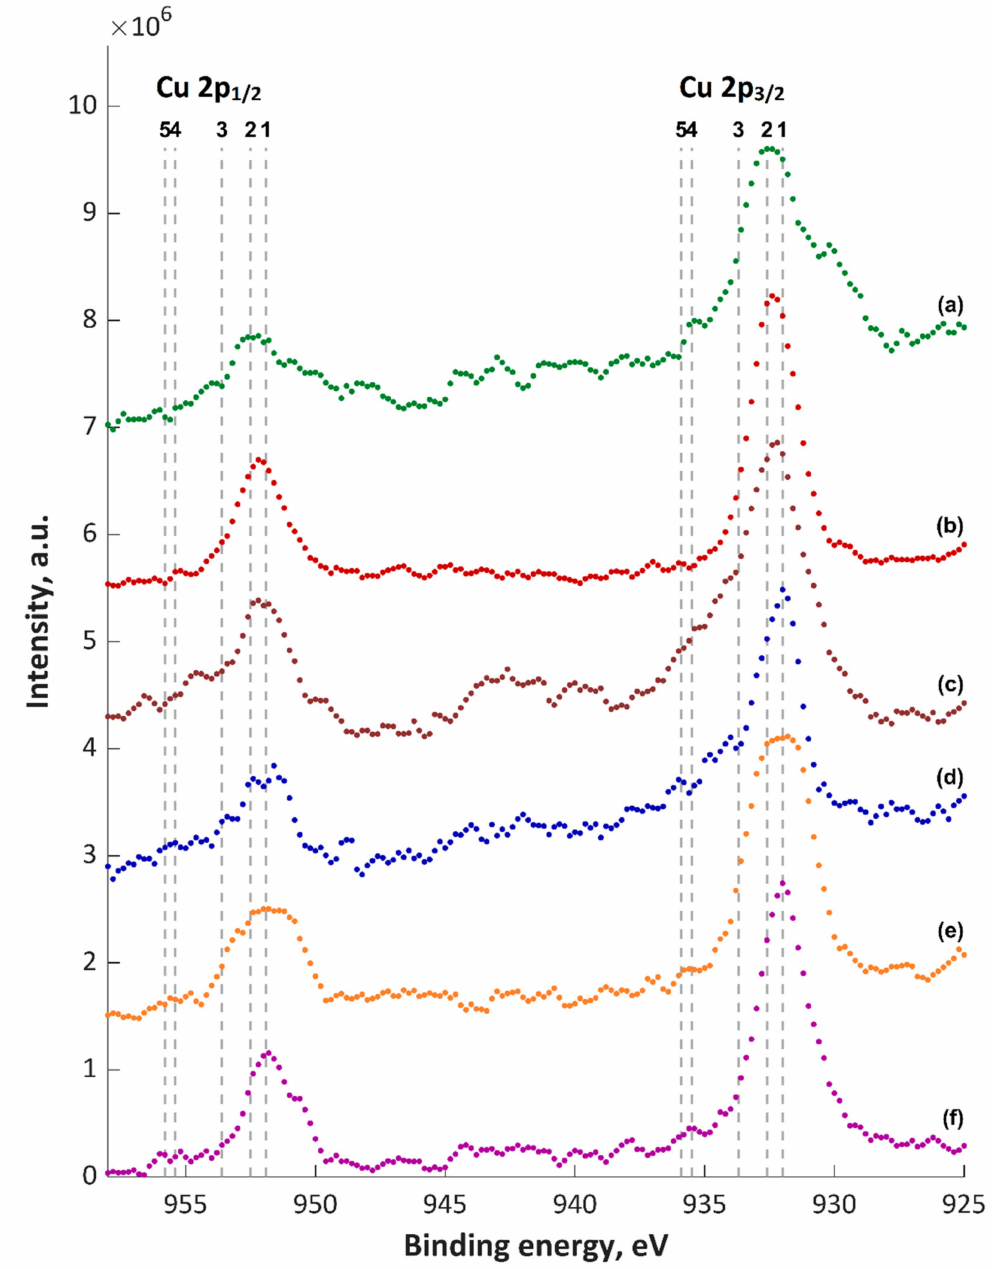
Figure 6. XPS Ti 2p spectra of PEO coatings: ( a ) TiZnCu-35; ( b ) TiZnCu-135; ( c ) TiZnCuCa-35; ( d ) TiZnCuCa-135; ( e ) TiZnCuMg-35; and ( f ) TiZnCuMg-135. 1, Cu 2 O; 2, CuO; 3, Cu(OH) 2 ; 4, Cu(NO 3 ) 2 ; 5, Cu 3 (PO 4 ) 2